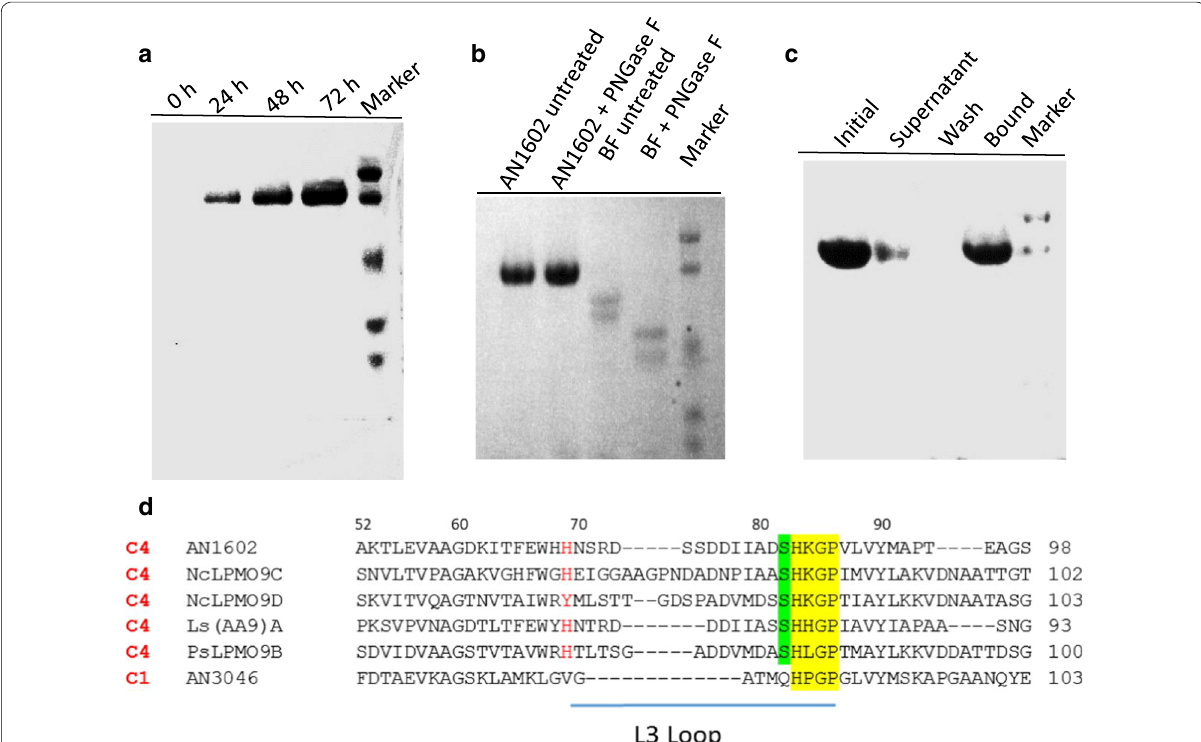
Fig. 1 Production of AN1602 in P. pastoris and analysis. a Time course of AN1602 secretion over a period of 3 days from P. pastoris cultures after induction with 1.0% methanol. Aliquots of P. pastoris culture media taken at 24 h intervals were assessed in SDS-PAGE gel under denaturing conditions. b SDS-PAGE analysis of purified AN1602. AN1602 protein was treated with PNGase F and loaded onto a denaturing PAGE gel as follows: purified AN1602 (lane1), AN1602 after PNGase F treatment (lane 2), bovine feutin (BF) (lane 3), BF after PNGase F treatment (lane 4), Marker—low molecular protein standard. Control reactions with BF in lane 3 and lane 4 shows the PNGase F enzyme is effective in deglycosylating BF. c Binding of AN1602 to insoluble cellulose. AN1602 protein was mixed with Avicel and incubated on ice for 3 h in sodium phosphate buffer and the PAGE gel was loaded as fractions containing initial starting material (lane 1), supernatant (lane 2), wash (lane 3) and protein bound to pellet (lane 4). Marker— low molecular protein standard. d Sequence features of AN1602. A partial multiple sequence alignment of selected LPMOs. The conserved [Hx n GP] motif containing the second His ligand of the copper active site is highlighted in yellow, and the conserved serine in green. The predicted L3 loop region is marked by a horizontal bar and the first residue of the loop is shown in red. Regioselectivity is (C1/C4) is indicated on the left based